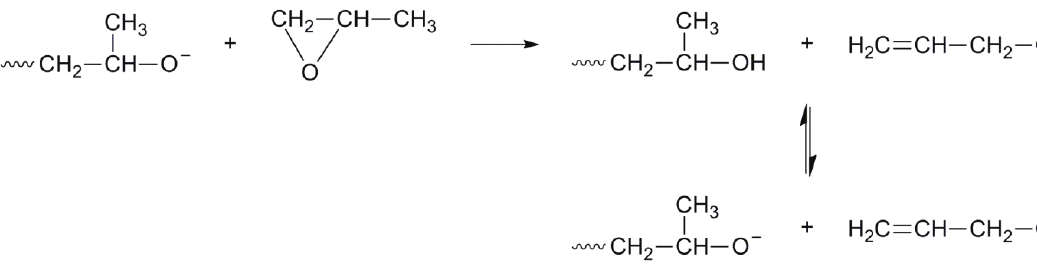
Figure 45. AROP of methyl oxiranes with chain transfer to monomer.